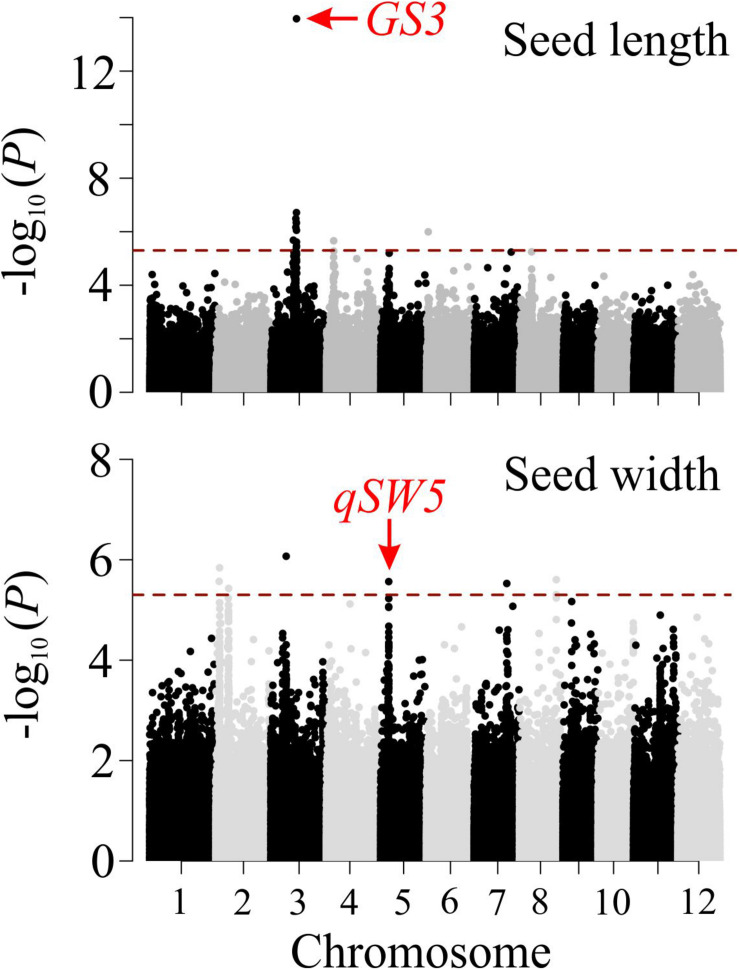
Manhattan plots of genome-wide association analysis for mature grain length (upper panel) and width (lower panel). The red dashed horizontal line indicates cut-off of significance threshold (P < 3.3 × 10– 6 or -log10(p) > 5.4) level. Previously known major seed length (GS3) and width (qSW5) regulators are highlighted with a red arrow.